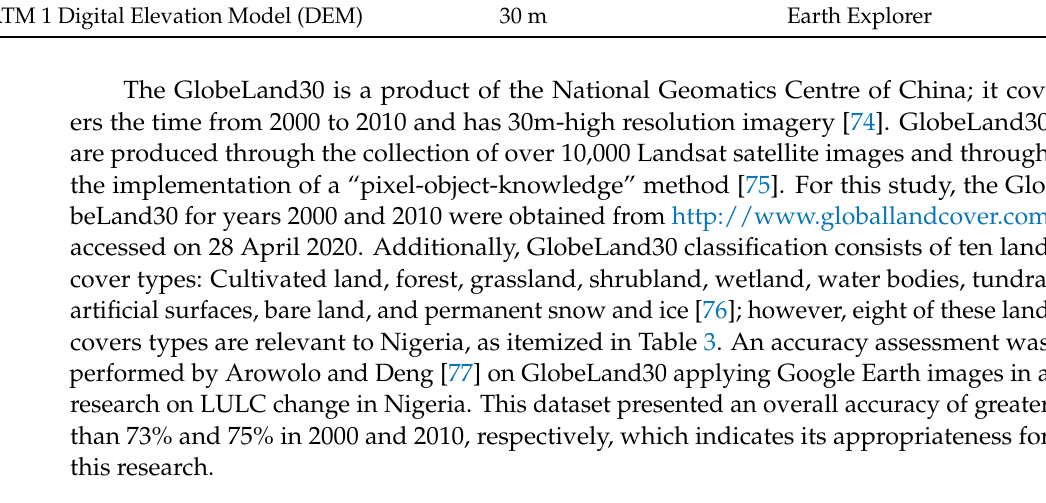
Table 3. Land cover classification of GlobeLand30 utilized for the study